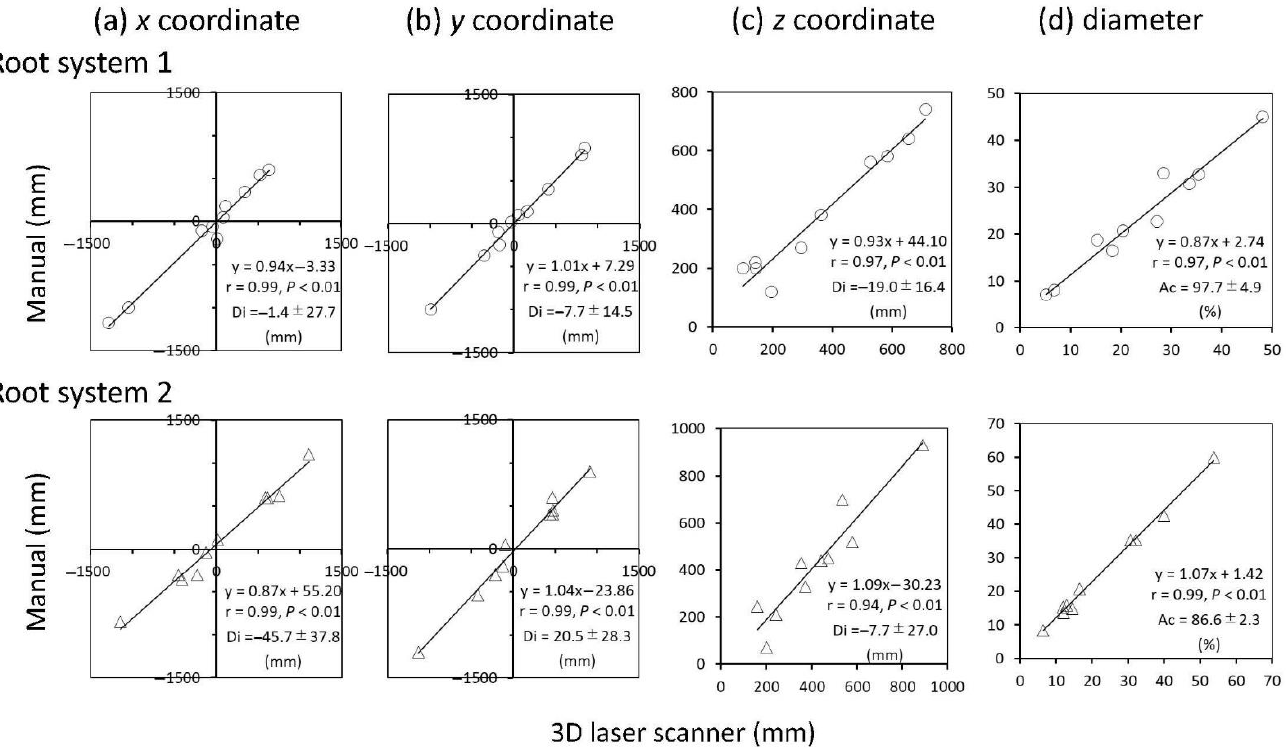
Figure 7. Relationships of ( a ) x , ( b ) y , ( c ) z coordinates, and ( d ) diameter of 10 selected root points between 3D laser scanner and manual measurements. The correlation coefficient (r) was calculated as the mean value estimated by 1000 bootstraps. The differences (Di, mean ± standard error) in distances from each coordinate obtained by the manual measurement to that of the 3D laser scanner were calculated at the 10 root points in each root system. The accuracy (Ac, mean ± standard error) of root diameter at 10 root points in each root system was defined as the percentage of the diameter estimated by the 3D laser scanner to that of the manual measurement according to Lau et al. [27].